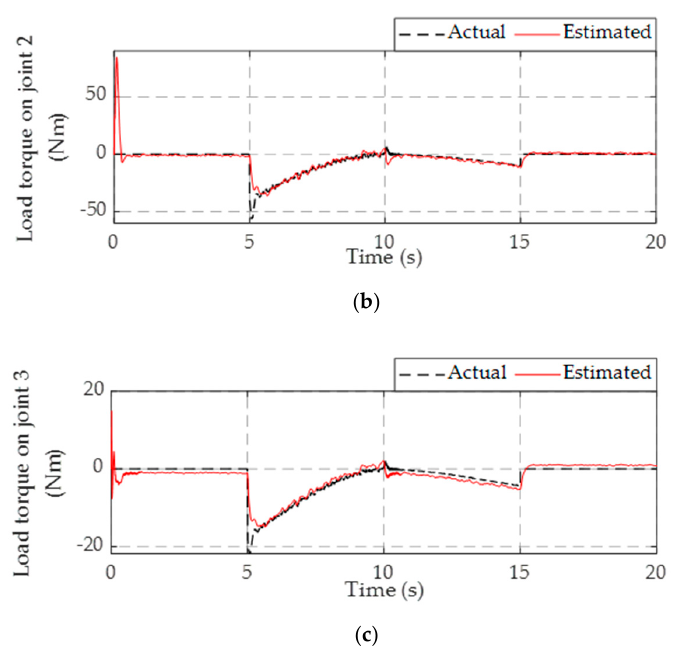
Figure 11. The load torque estimated of the: ( a ) first joint, ( b ) second joint, and ( c ) third joint.